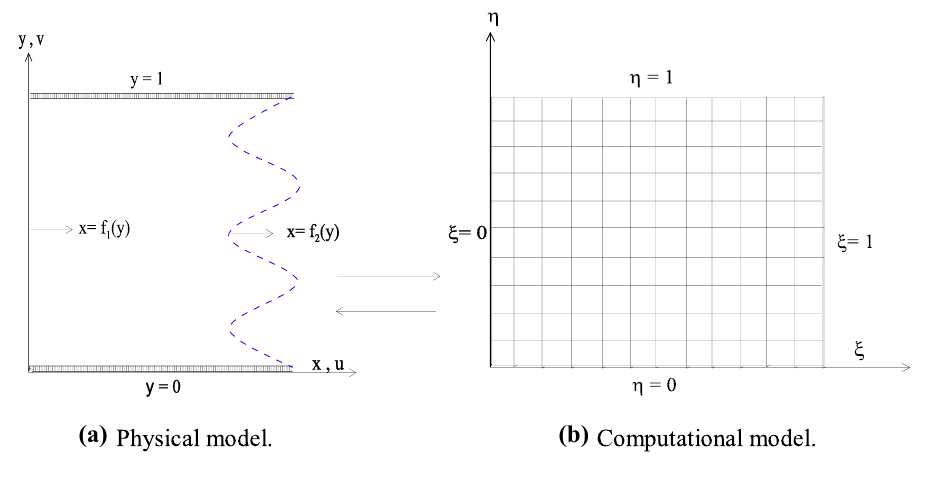
Fig. 3 Comparison between the present results (right) and those obtained by Cheong et al. [74] (left)